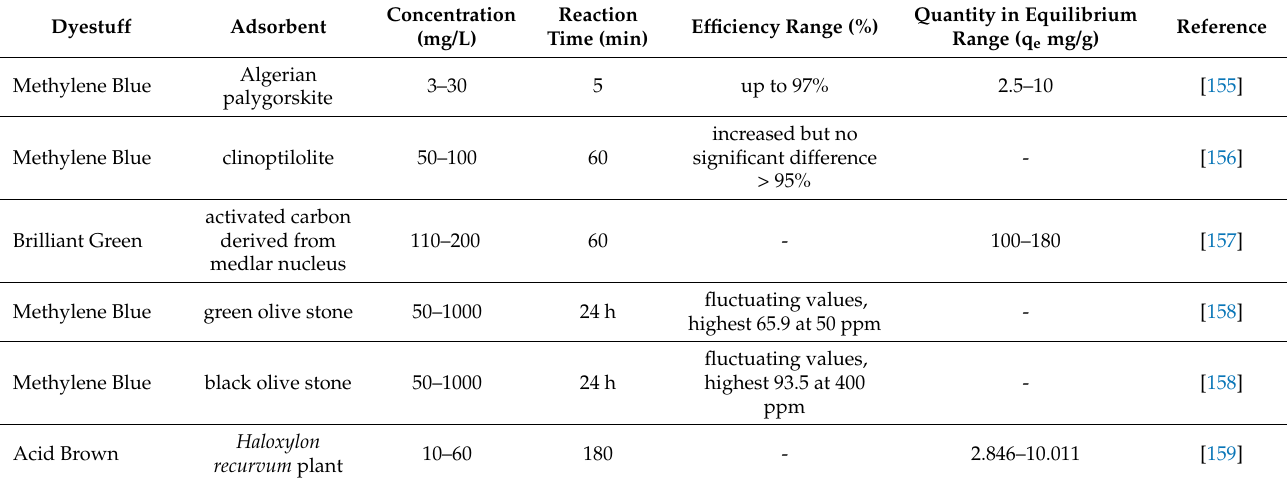
Table 1. Results of various research regarding the effect of initial dye